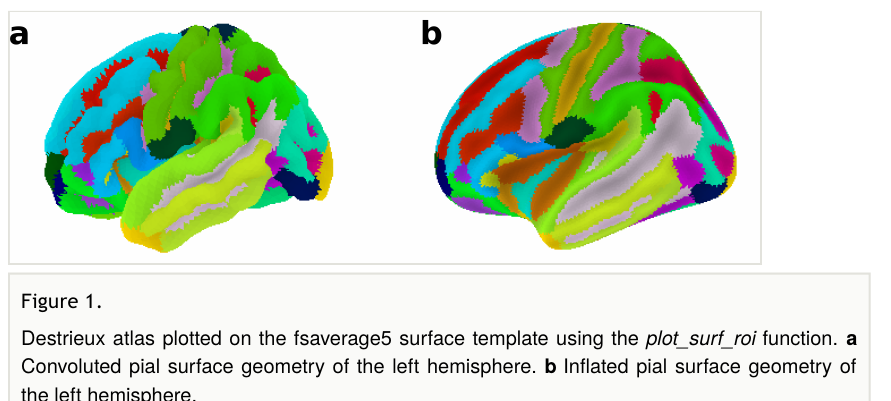
Destrieux atlas plotted on the fsaverage5 surface template using the plot_surf_roi function. a Convoluted pial surface geometry of the left hemisphere. b In fl ated pial surface geometry of the left